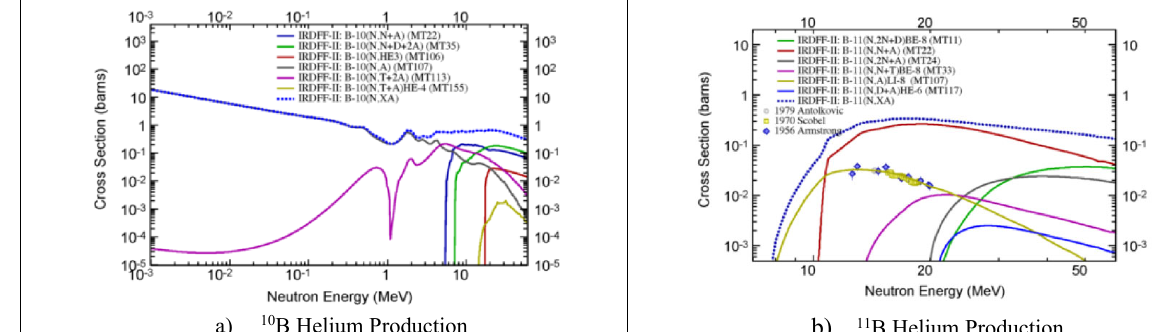
Fig. 3. Helium production in the boron isotopes [3]